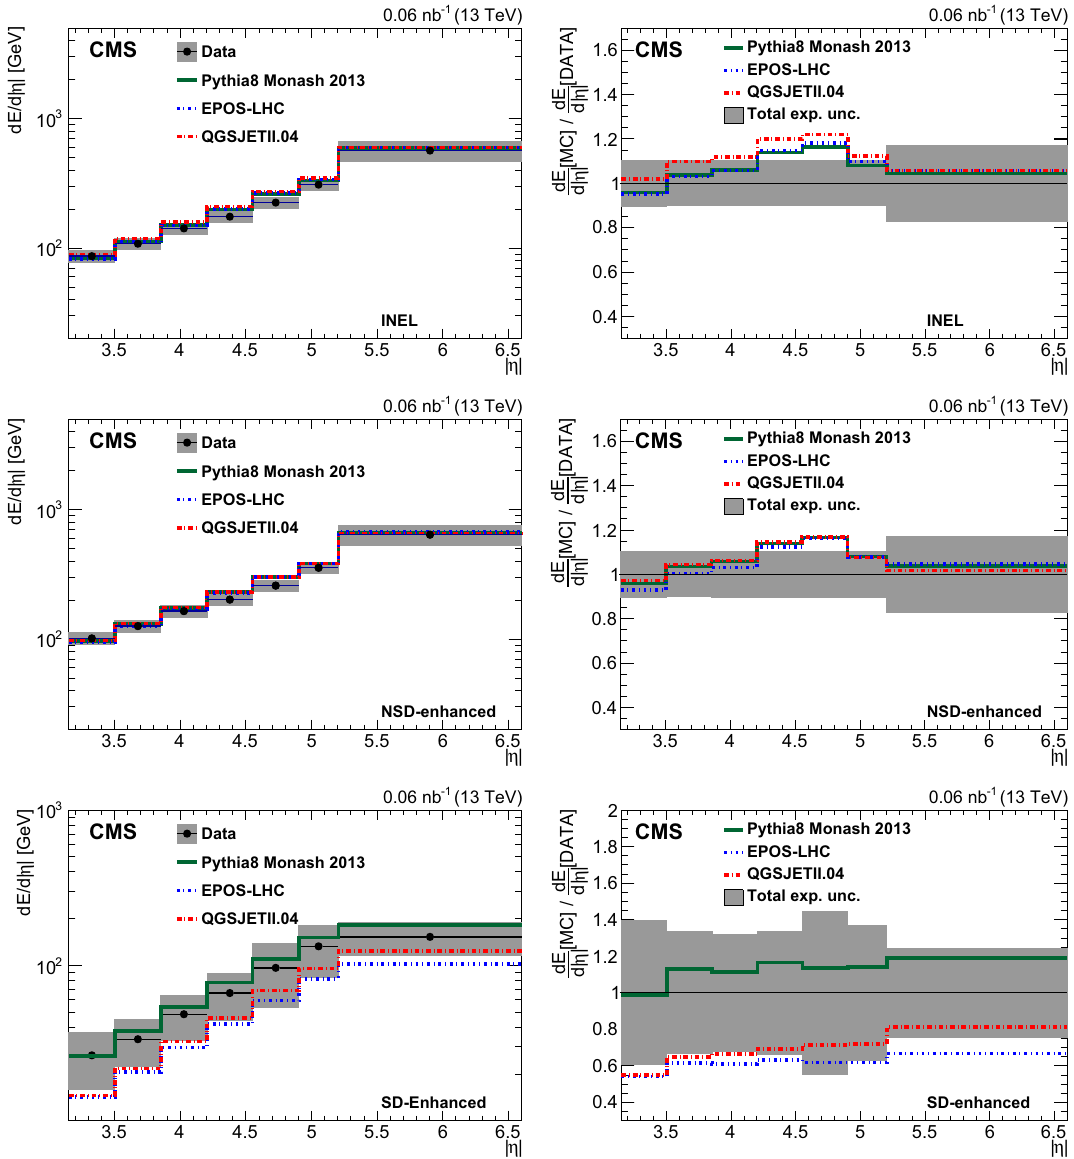
qgsjetII.04 . The gray band shows the total systematic uncertainty. The Fig. 2 Energy density at the stable-particle level for the INEL (upper row), NSD-enhanced (middle row), and SD-enhanced (lower row) cate- right panels show the ratio of model predictions to measured data gories compared to predictions from pythia 8 monash , epos- lhc , and energy E T = E cosh (η) per tower is used instead of just the tower energy E . In Fig. 4 the resulting corrected transverse energy density, d E T / d η (cid:5) , is compared to earlier published √ s and to model predictions, as a func- CMS data at lower tion of the shifted pseudorapidity variable η (cid:5) = η − y beam